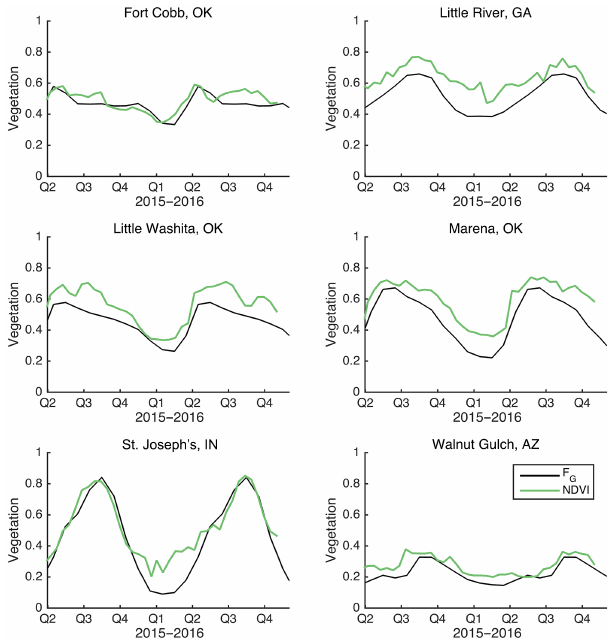
Figure 11. NDVI and F G at six sites in the study domain.